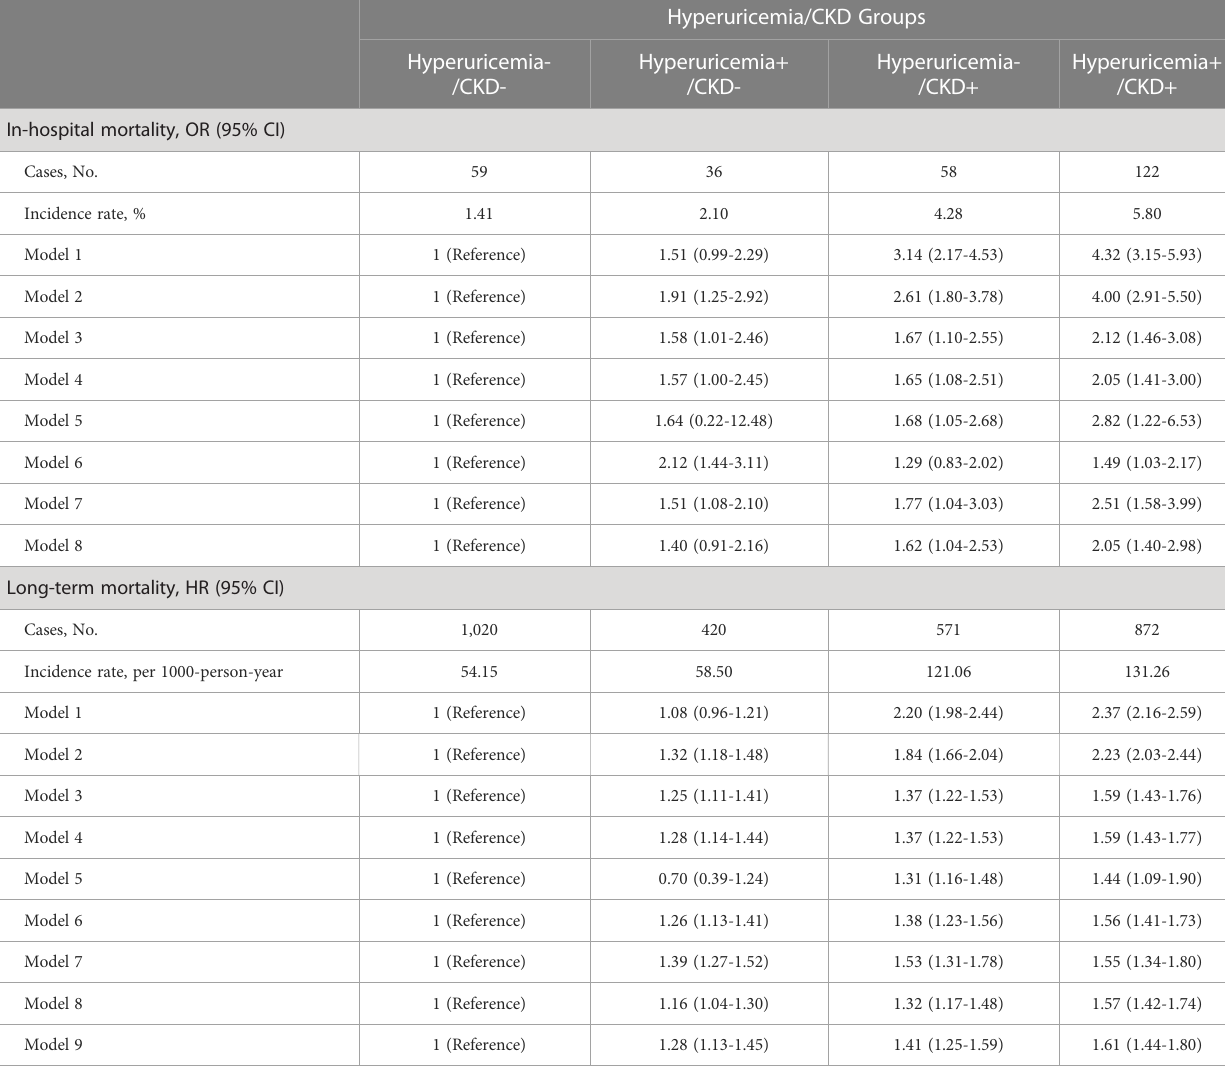
TABLE 2 Risk of in-hospital mortality and long-term mortality according to hyperuricemia/CKD groups.